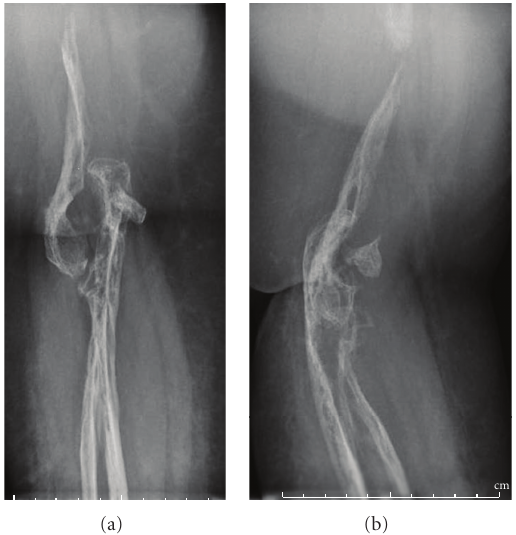
Figure 3: Anteroposterior and lateral plain radiographs of the elbow showing dislocation of the humeroulnar joint and fragmen- tation and disappearance of the distal humerus.